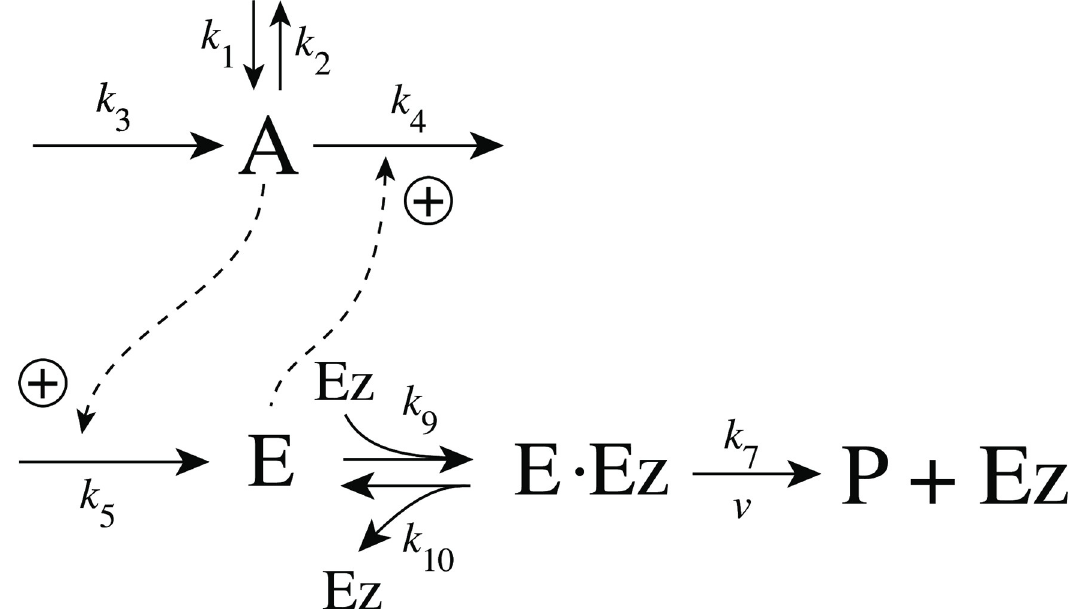
Fig 30. Reaction scheme of the catalyzed single-E m5-type of